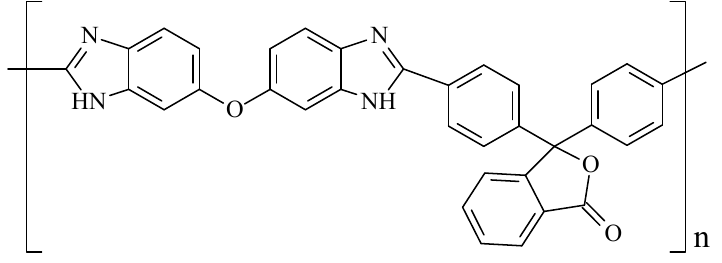
Figure 1. Cardo PBI (PBI-O-PhT) chemical structure.